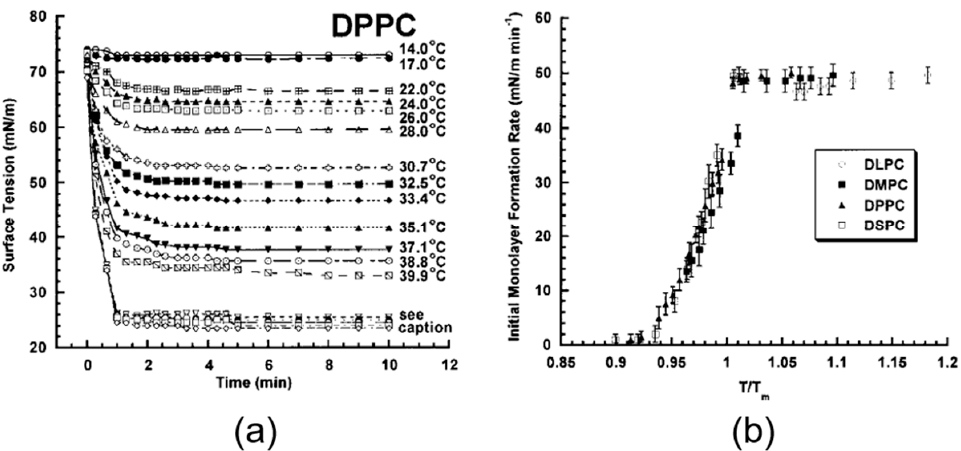
Figure 19. Dynamic surface tension change and initial monolayer formation rates. (a) Effect of temperature on adsorption kinetics at the water ‐ air interface of DPPC monolayers, as monitored by change in surface tension with elapsed time of exposure of the interface to DPPC lipid aqueous suspensions (1.0 mM) at various temperatures from 14 to 59.6 °C. Note: the surface tensions at (43°C ( ), 45 °C ( ● ), 47 °C ( ○ ), 51.1 °C ( □ ), and 59.6 °C ( ◊ ) all rapidly reached an equilibrium value of 25 mN/m within 1 to 2 min, and so the data effectively lies on top of each other. (b) Plot of the initial monolayer formation rates of four different lipids, i.e., DLPC, DMPC, DPPC, and DSPC, at the air-water surface as a function of their relative phase transition temperature ( T/T m ). The four different types of lipid data were collapsed to a single curve. Reproduced from Lee et al. [6], with permission from American Chemical